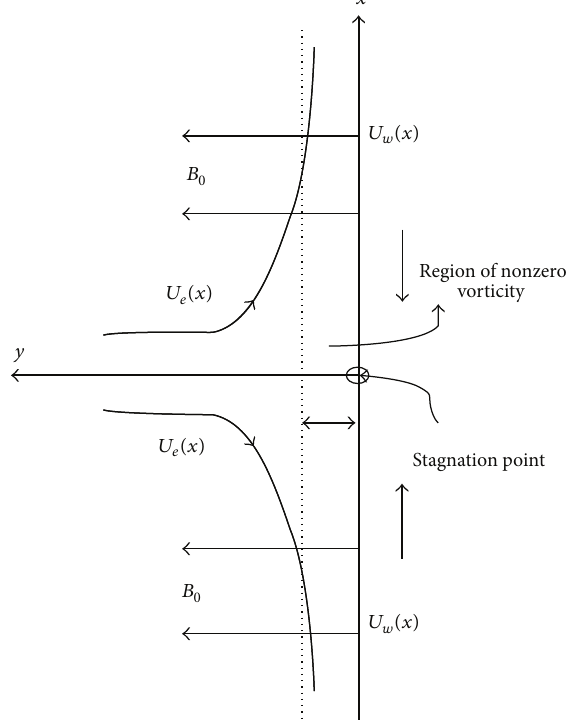
Figure 1: Schematic diagram of the